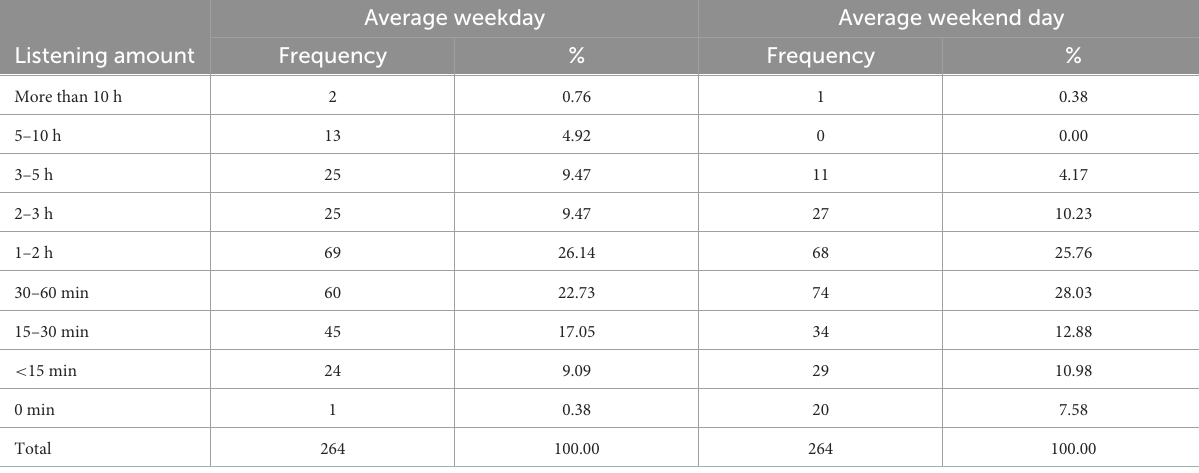
TABLE 3 Amount of time participants spend listening to podcasts using a smartphone on average weekdays and weekend days ( N =